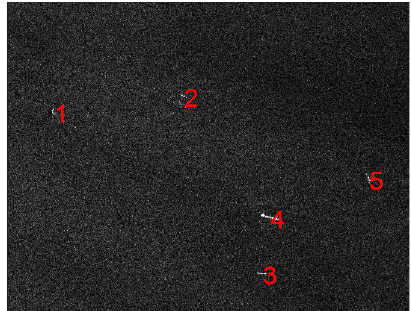
Figure 26. Configuration of TanDEM-X bistatic system.